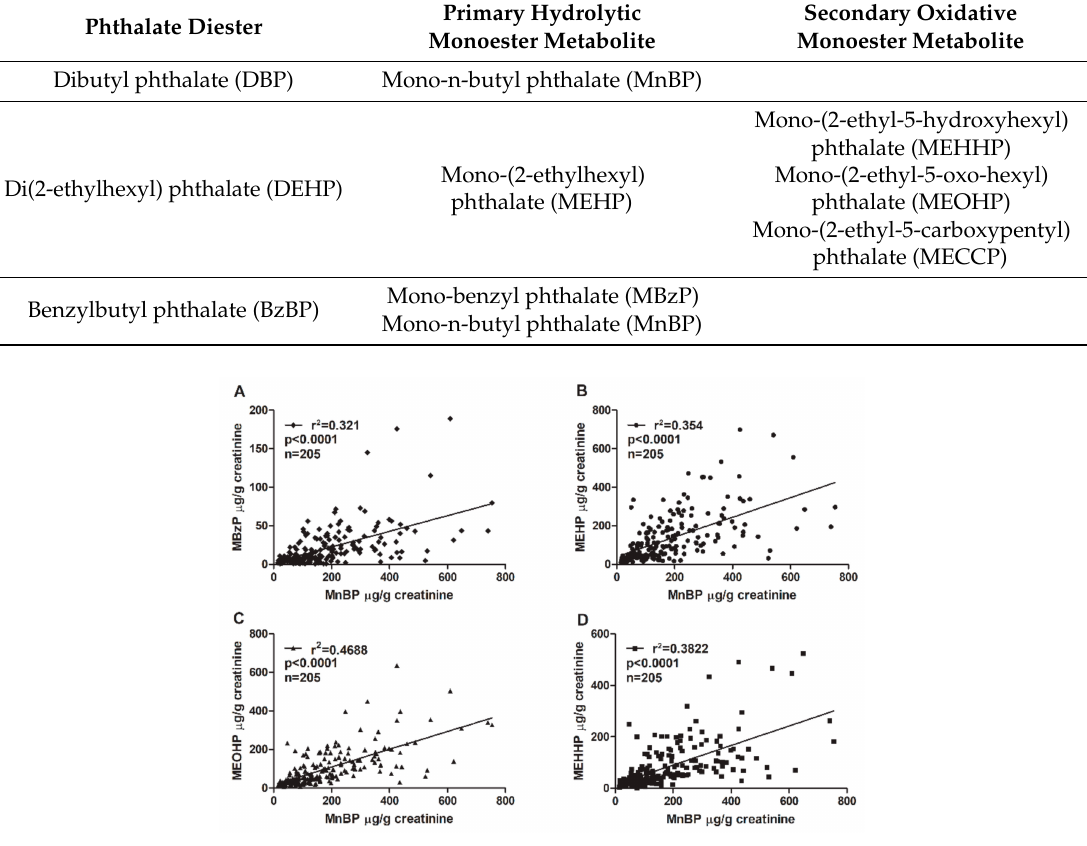
Figure 1. CorrelationsbetweenurinaryMnBPconcentrationandtheconcentrationsof( A )MEHP,( B )MBzP, ( C ) MEOHP, and ( D ) MEHHP. The total sample size was 205. The coefficient of determination ( r 2 ) was (A) 0.321, (B) 0.354, (C) 0.4688, and (D) 0.3822. All correlations had p values < 0.0001. Mono-n-butyl phthalate (MnBP), mono(2-ethylhexyl) phthalate (MEHP), monobenzyl phthalate (MBzP), mono(2-ethyl-5-oxo-hexyl) phthalate (MEOHP), and mono(2-ethyl-5-hydroxyhexyl) phthalate